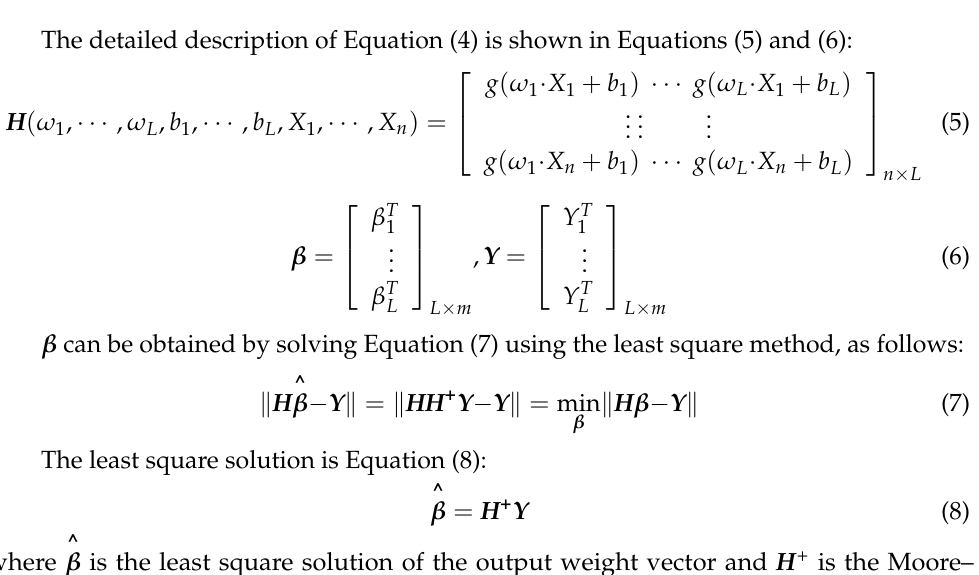
Figure 3. Schematics of extreme learning machine.